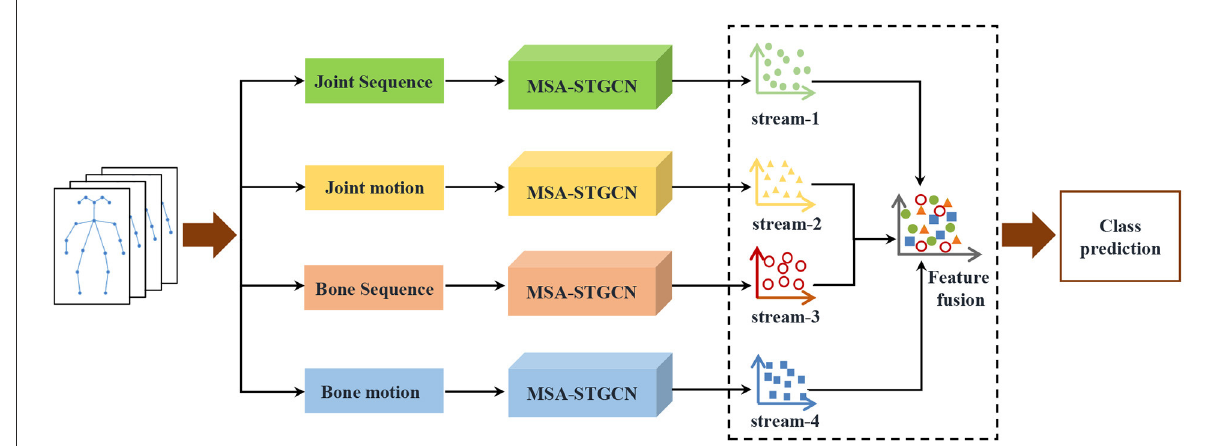
FIGURE1 Multi-stream fusion violence action recognition framework.